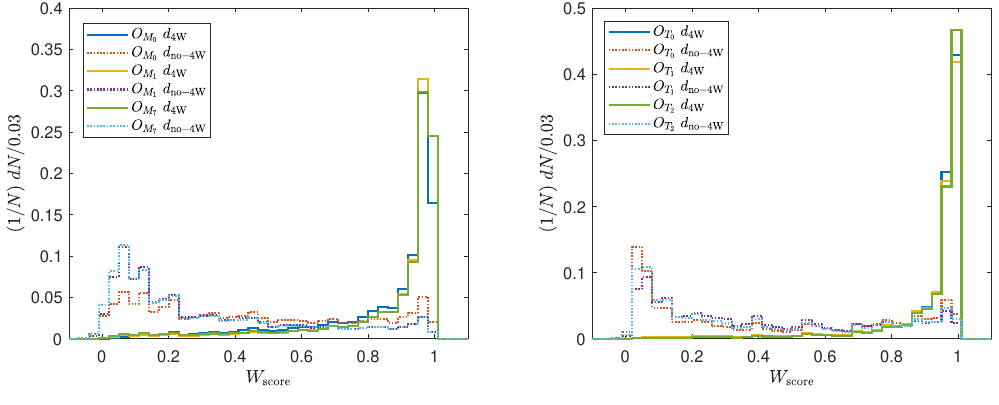
Figure 5 . The normalized distributions of W score